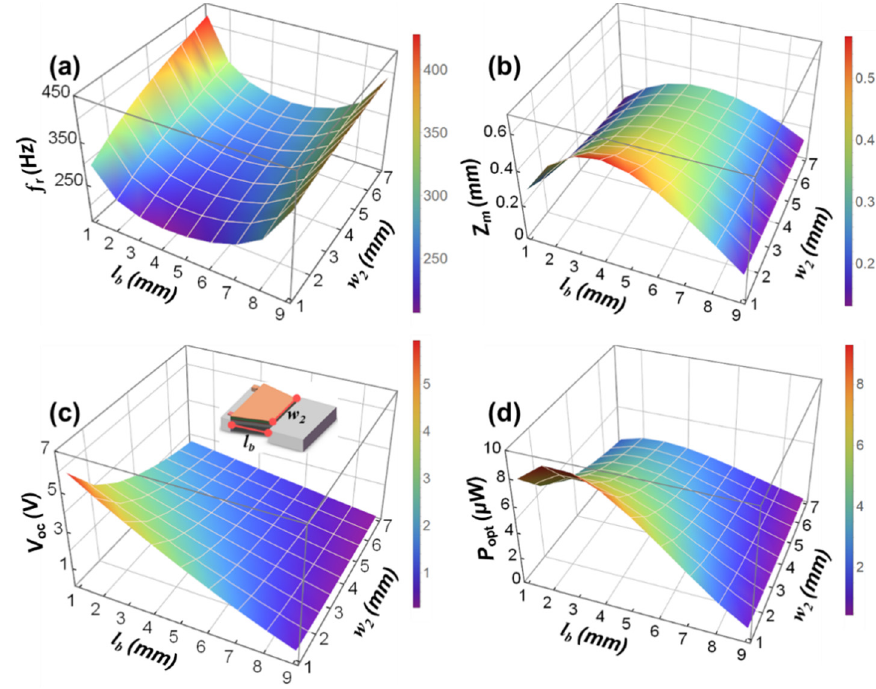
f ( a ), the maximum displacement of the tip mass r V ( c ), and the optimal load output power P ( d ) of the MEMS oc opt l and w . b 2